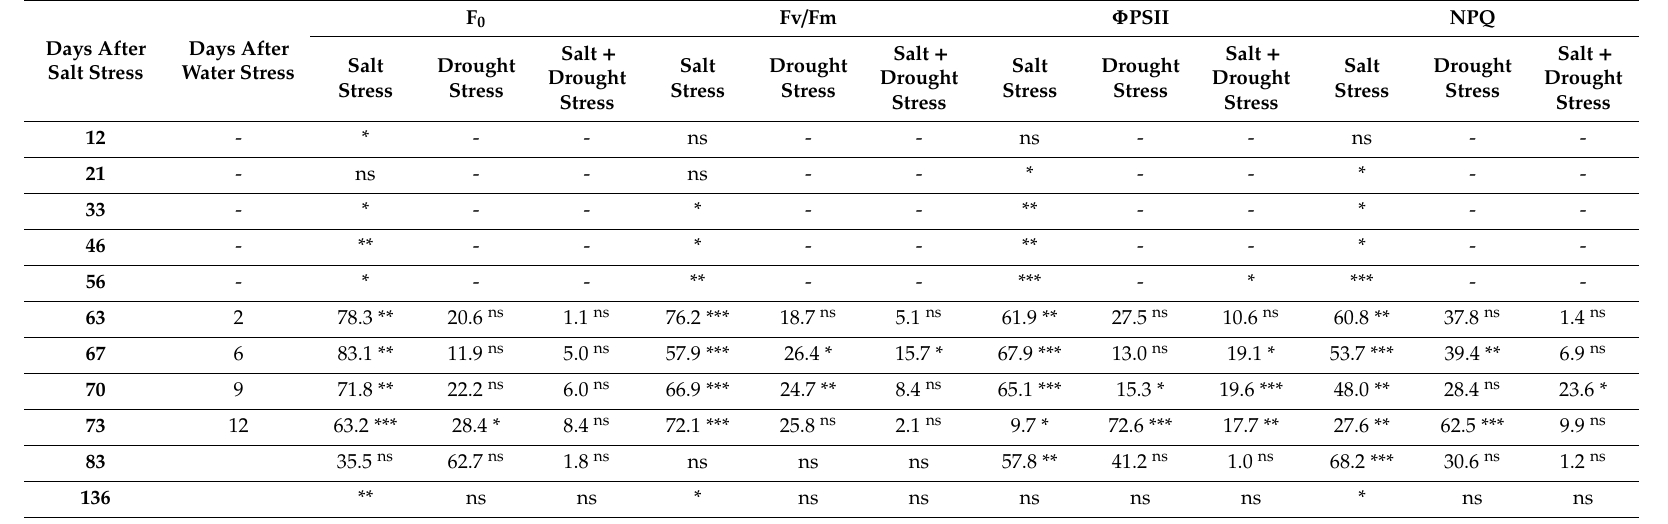
Table 3. Results of linear mixed model analysis of variance, shown as percentage (%) of the variance loaded on fixed factors and interactions, for F 0 , Fv / Fm, Φ PSII, and NPQ for each day after